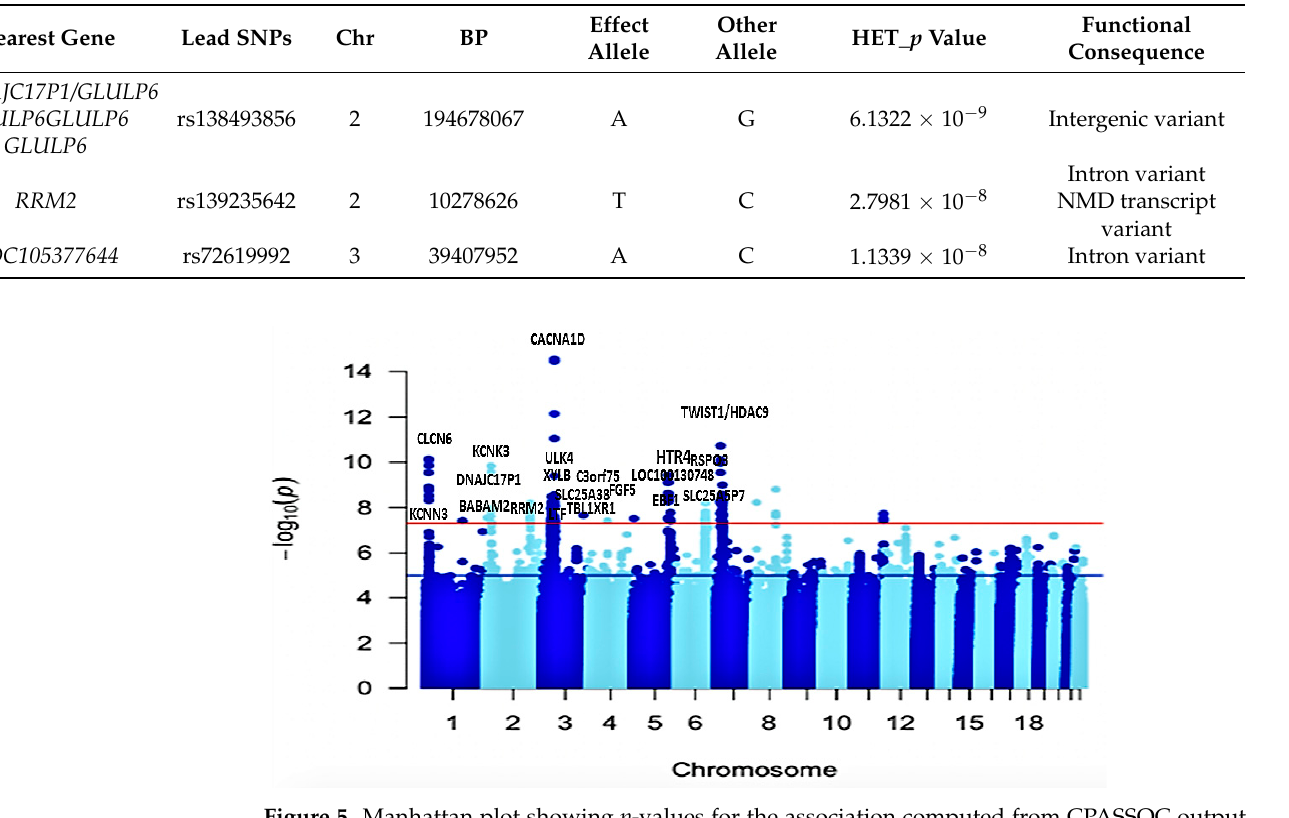
Figure 5. Manhattan plot showing p -values for the association computed from CPASSOC output results. Each point on the Manhattan plot denotes a variant, with the X -axis representing the genomic position and the Y -axis representing the association level − log 10 ( p -value). The horizontal red line shows the genome-wide significance threshold p -value = 5 × 10 –8 .